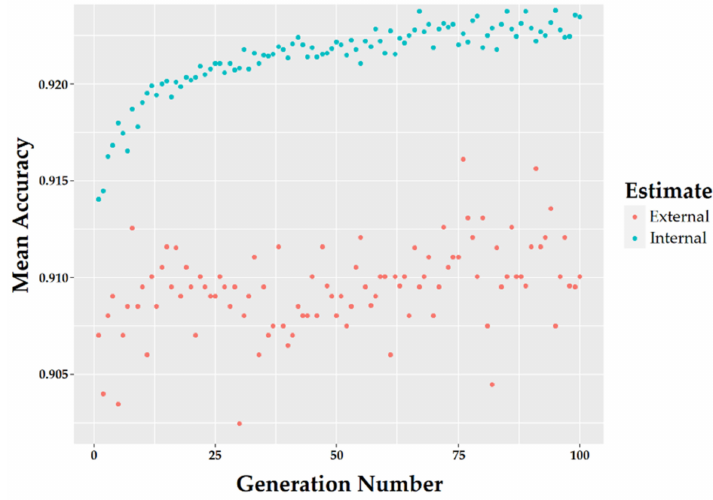
Figure 6. Feature selection using GA with 100 iterations. Red dots represent external performance estimates while blue dots are estimates of mean internal performance of each iteration. Table 5. Optimal hyperparameters for each machine learning algorithm and libraries used.